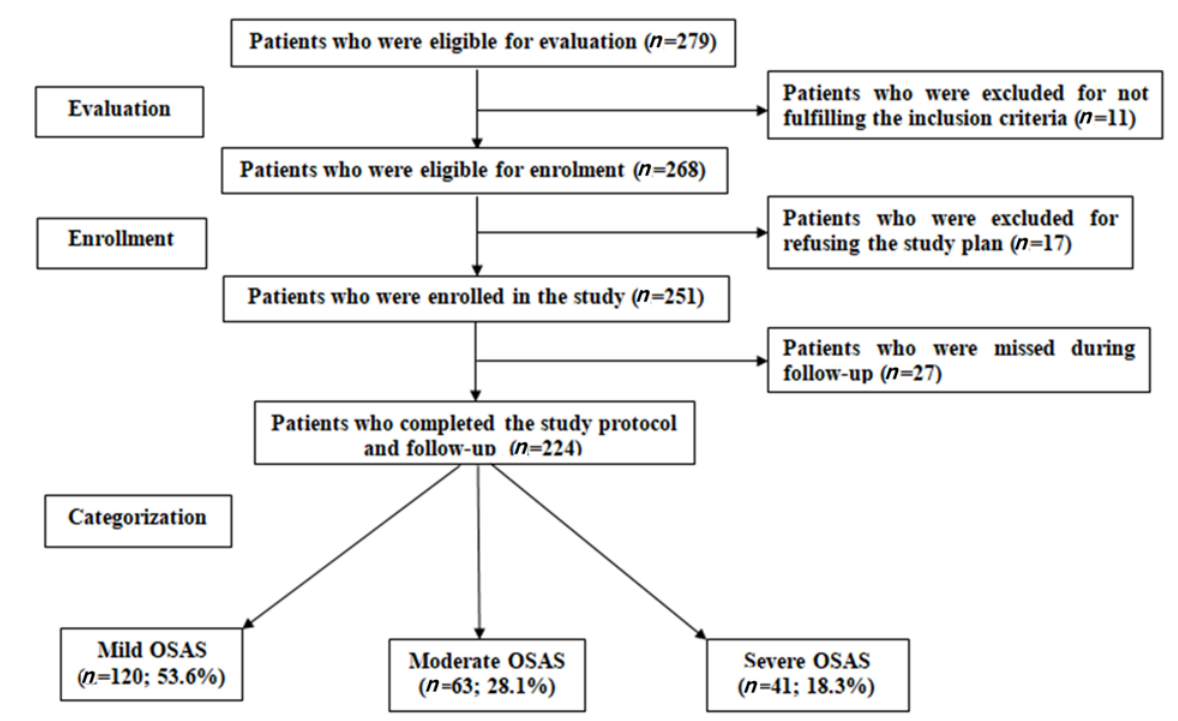
Figure 1. Study flow chart.